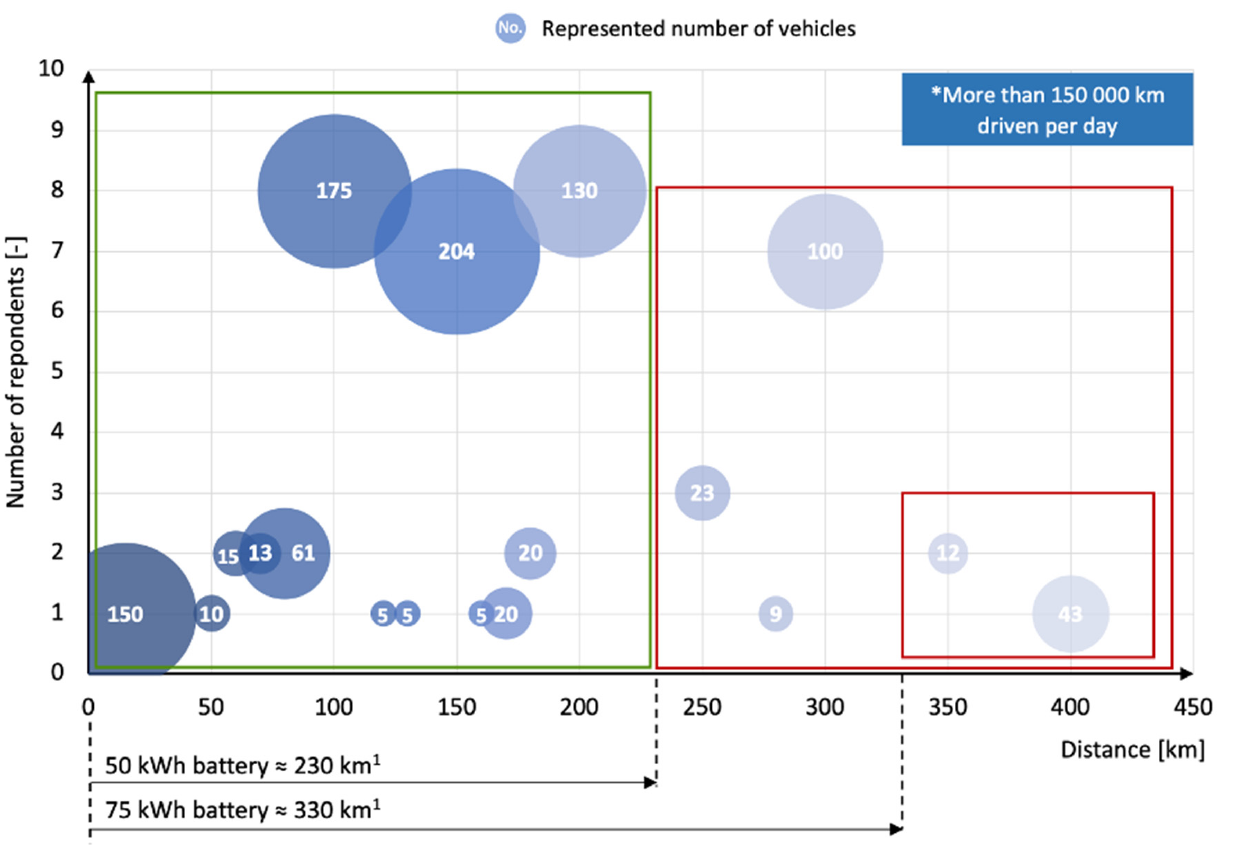
Figure 2. Number of vehicles managed by each fleet and their average daily distance, indicating the potential of different versions of a battery capacity to meet vehicle range requirements as well as the range of electrification potential in particular companies (based on the survey). 1 Electric range ensured by the manufacturer for Toyota Proace Electric with 16” steel wheels. It is highlighted that these figures may not reflect real driving conditions (RDCs). Electric range depends on accessories package, driving style, conditions, speed, load, etc. [30].